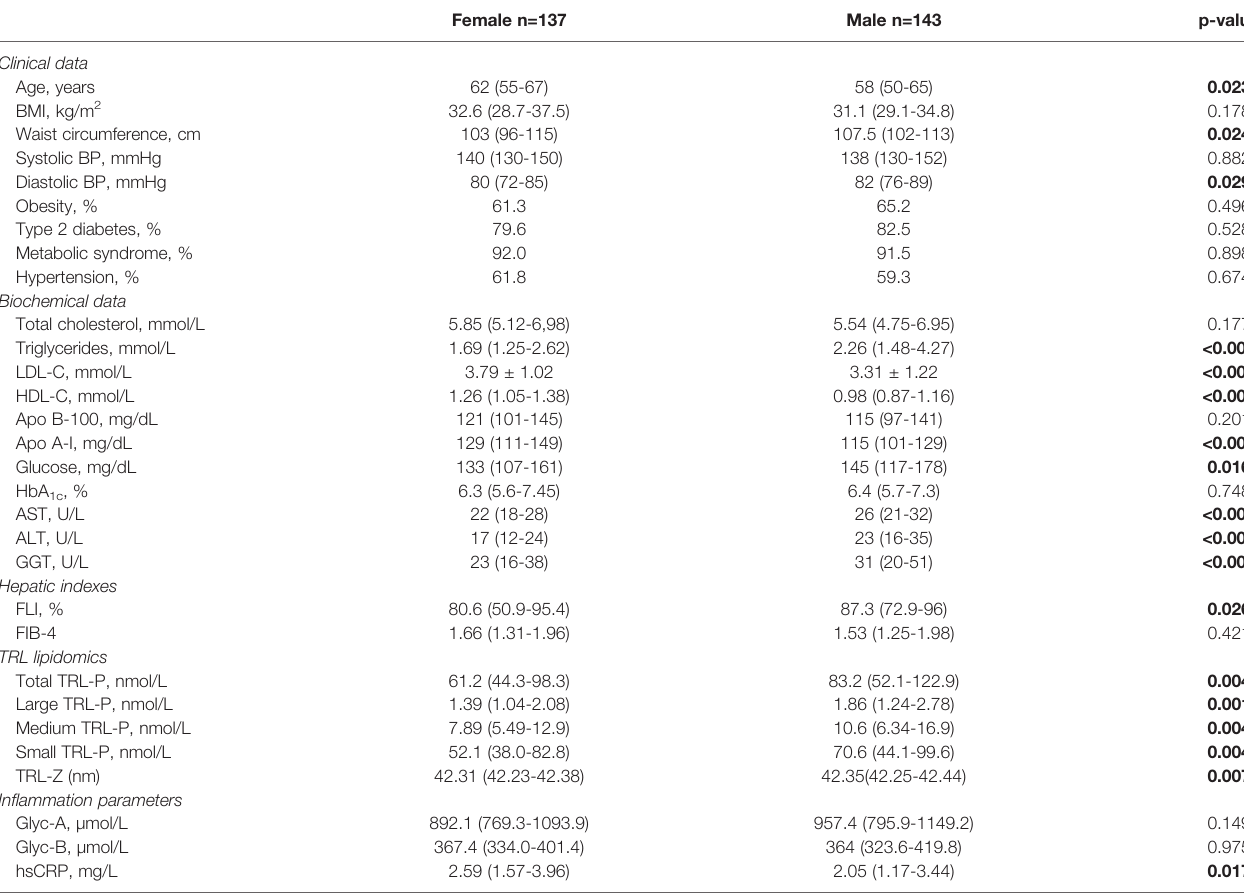
TABLE 1 | Clinical, anthropometric, and biochemical characteristics of the study population grouped by sex. Female